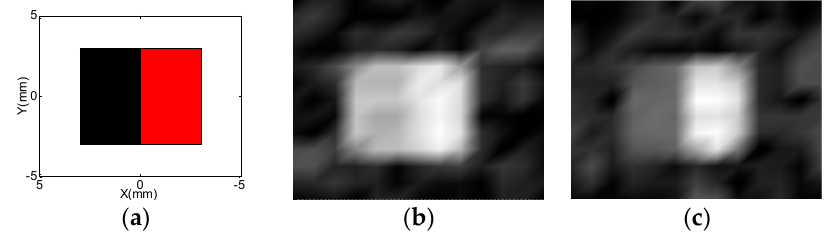
Figure 8. ( a ) Two different kinds of dead pig skin were used to build a burn model. The left half was cut from the abdominal skin of dead pig and used as the control part. The right half was built of the abdominal skin of dead pig immersed in boiling water for 10 seconds to produce full-thickness burns. The T 2 of the control part was about 19 ms and the T 2 of the burn part increased to about 35 ms. The images obtained by adding ( b ) the echoes 0–20 and ( c ) the echoes 200–400 show different intensity ratios between the two regions.